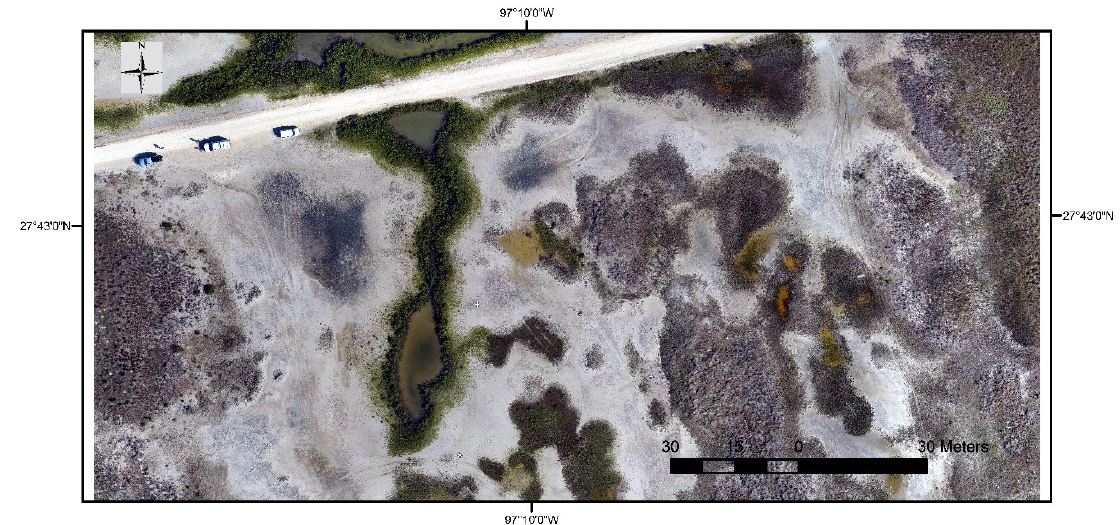
Figure 2. Orthomosaic aerial image of the study area at Mustang Island Wetland Observatory on 20 December 2017. Aerial imagery was acquired from a small-unmanned aircraft system (UAS), DJI Phantom 4 Pro, equipped with a 20 MP RGB camera.